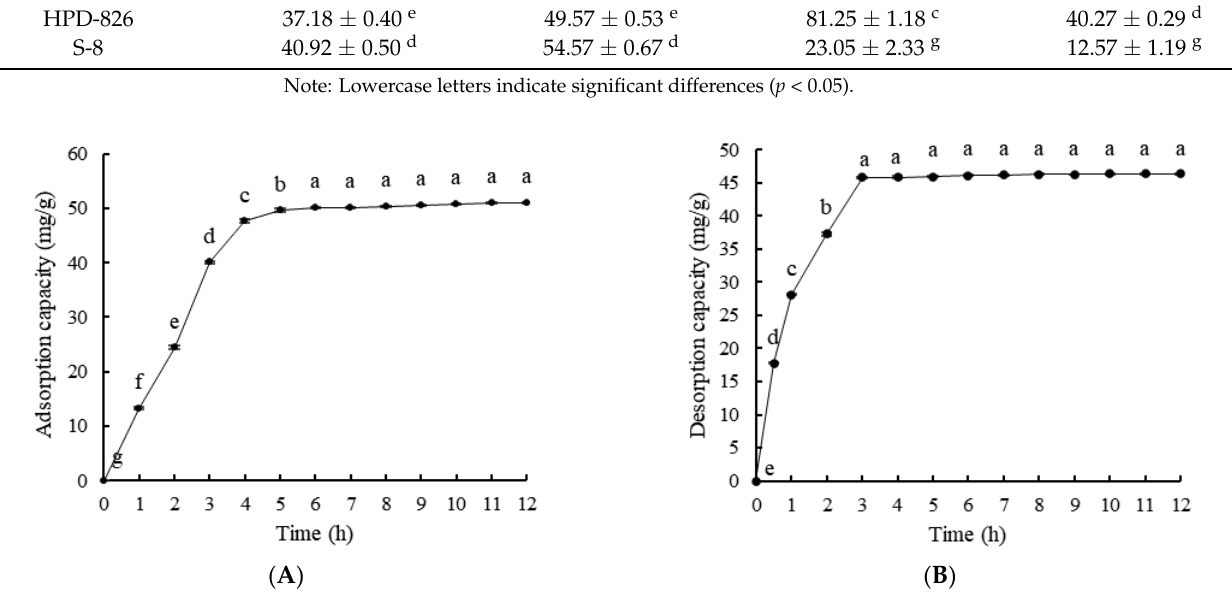
Figure 3. Kinetic curve of static adsorption ( A ) and desorption ( B ) of monoterpene glycoside extract from P. suffruticosa seed meal. Lowercase letters indicate significant differences ( p < 0.05).